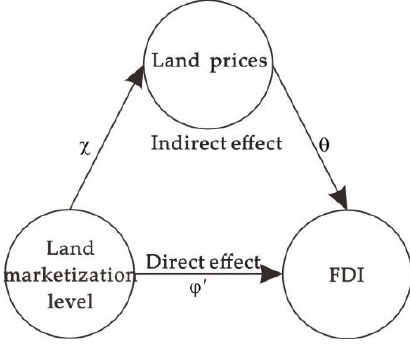
Figure 1. Mediation model.